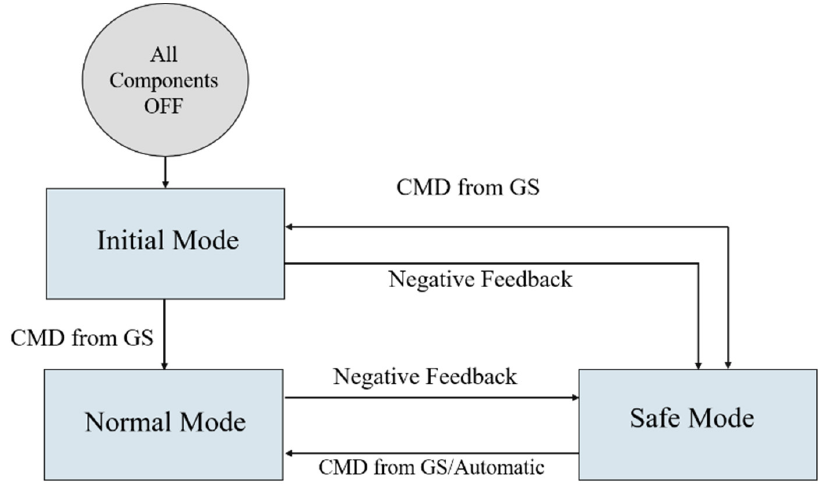
Figure 1. Modes of